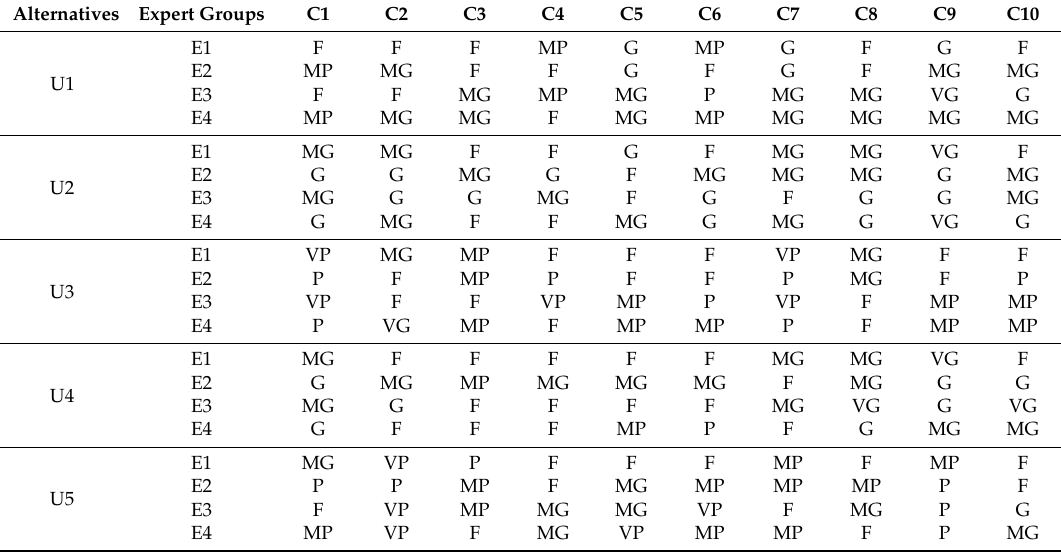
Table 13. Linguistic judgments of five alternatives for criteria performances.